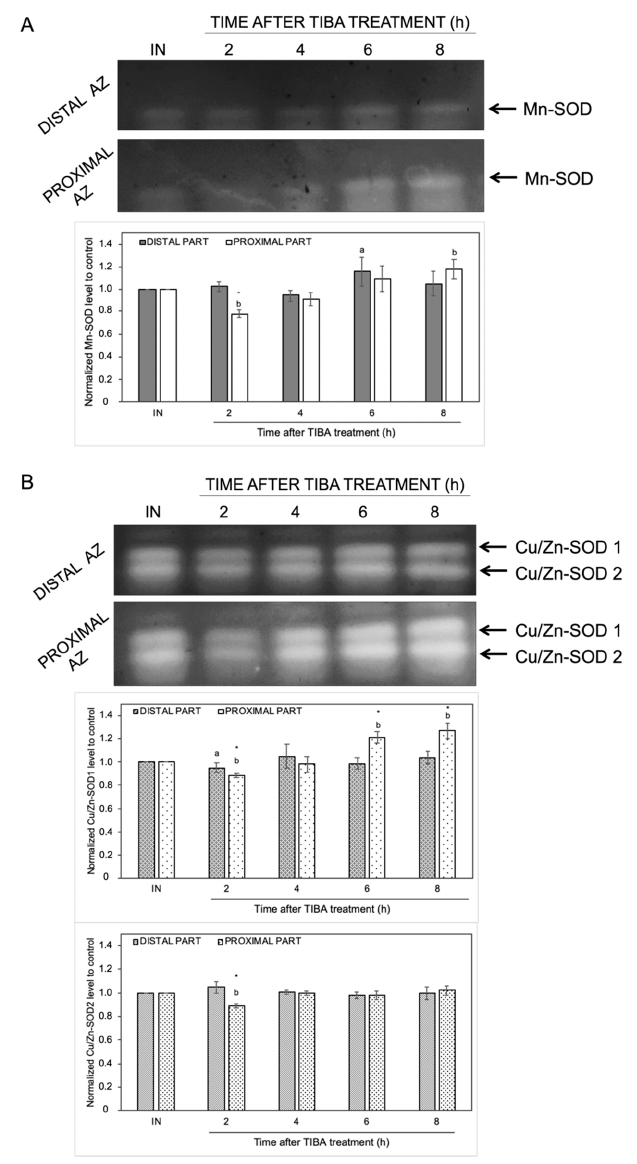
Figure 6. The response of distal and proximal parts of the flower AZ to the inhibition of polar auxin movement involved superoxide dismutase (SOD) activity. The SOD isoenzyme profile was obtained for the distal and proximal parts of the AZ. Tween 20 solution (0.05%) was applied directly to the inactive AZ (IN) and material was collected after 8 h. An inhibitor of polar auxin transport, namely 2,3,5-triiodobenzoic acid (TIBA, 0.05 mM in 0.05% Tween 20), was also applied to the IN AZ and tissues were excised 2, 4, 6, and 8 h after treatment. Mn-SOD ( A ) and two isoforms of Cu/Zn-SOD ( B ) were detected using in-gel assays (representative micrographs of nitroblue tetrazolium (NBT)-stained gel are presented). The charts below the pictures display the average